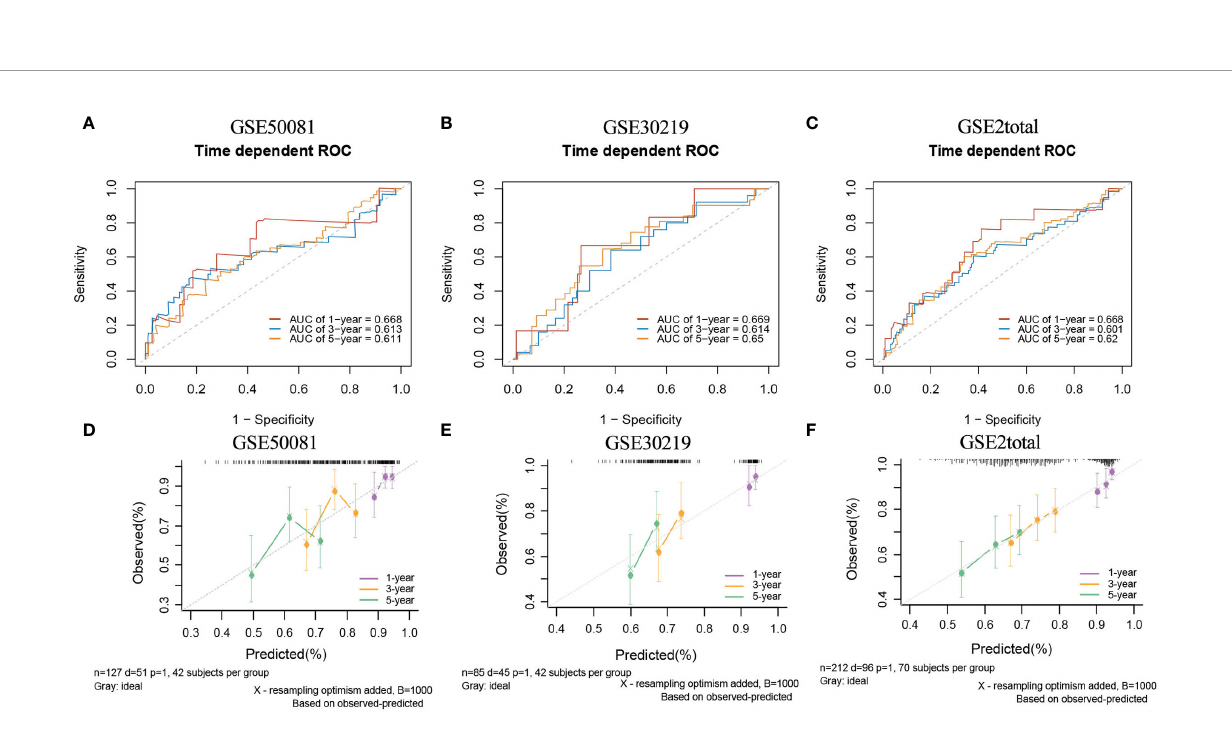
FIGURE 10 | The ROC curves and calibration plots of lncRNA model in external validation data sets. ROC curves at 1-,3-,5-year: (A) GSE50081 dataset, (B) GSE30219 dataset, and (C) GSE2total dataset. The calibration plots at 1-,3-,5-year: (D) GSE50081 dataset, (E) GSE30219 dataset, and (F) GSE2total